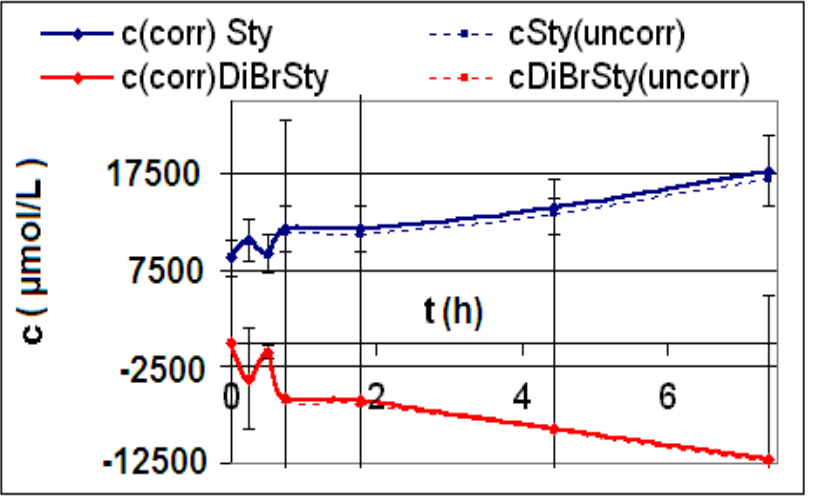
( t ) /c ( t ) . corr uncorr